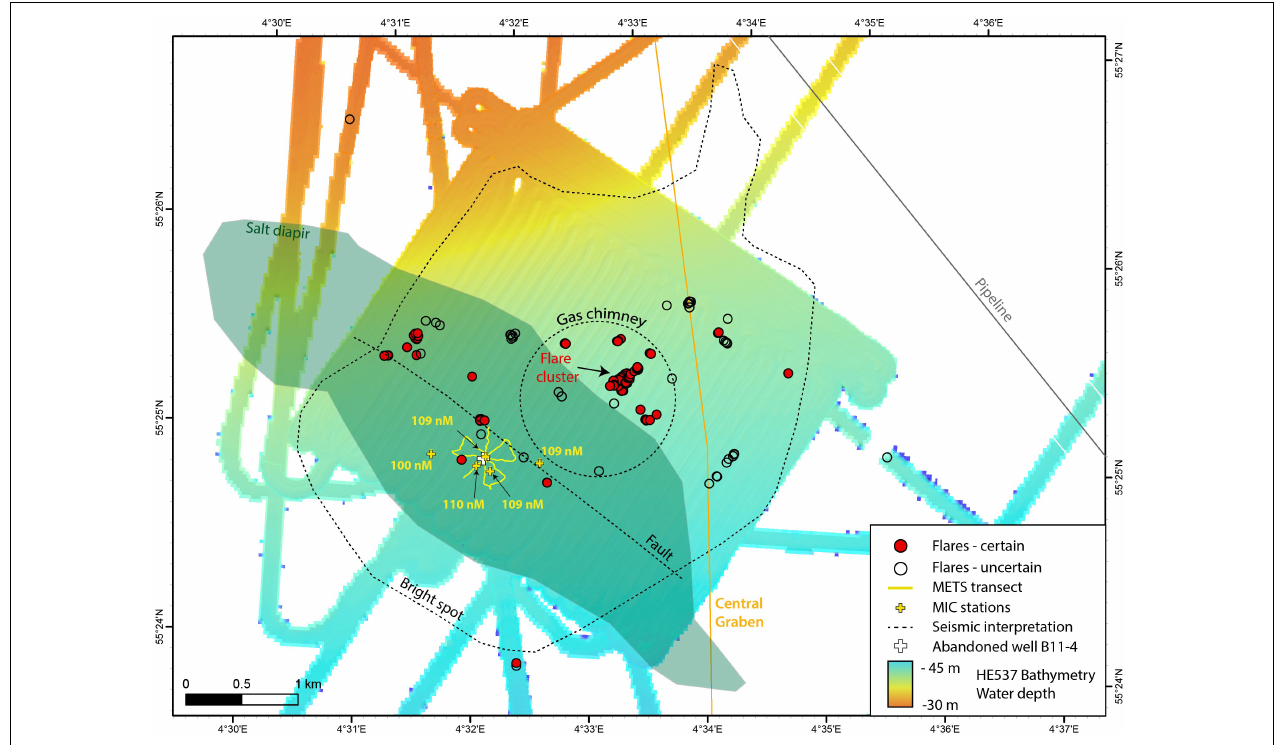
FIGURE 10 | Map compiling data acquired at salt diapir Berta, where most of the flare findings were concentrated. Seismic interpretation (bright spot extent, subsurface fault indication, and gas chimney) was depicted from Figure 7 in Müller et al. (2018). Bottom water methane concentrations (yellow numbers) do not increase toward the well